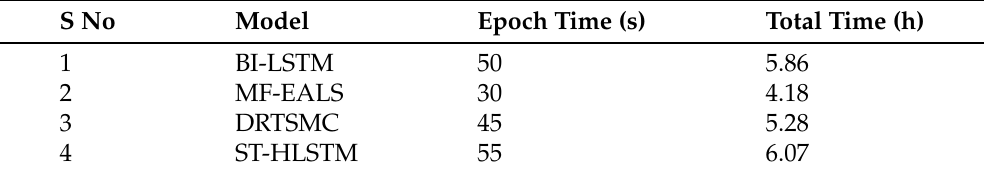
Table 4. Training time for the multiple data recovery approaches.